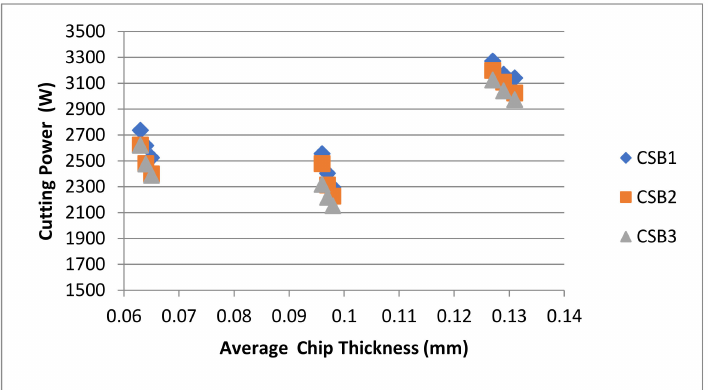
Figure 6. Dependence of the cutting power on the mean chip thickness at all nine cutting